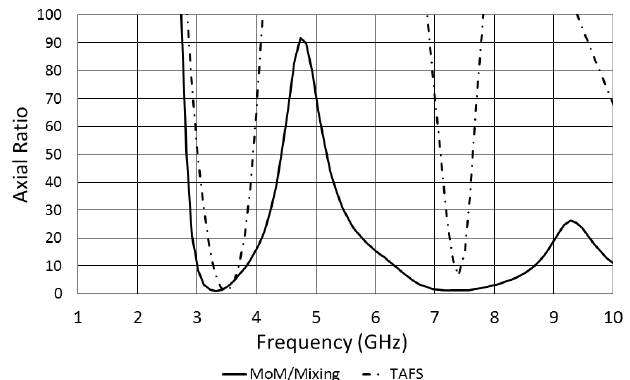
Figure 6: Predicted Axial Ratio of 1.9 cm Thick Dielectric Slab Loaded with 3-Turn 30º Conical Coil